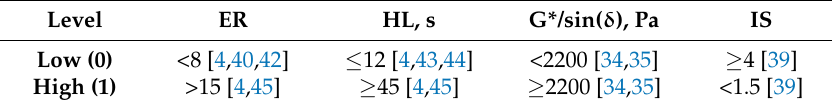
Table 8. Limiting ranges of utility profiles.